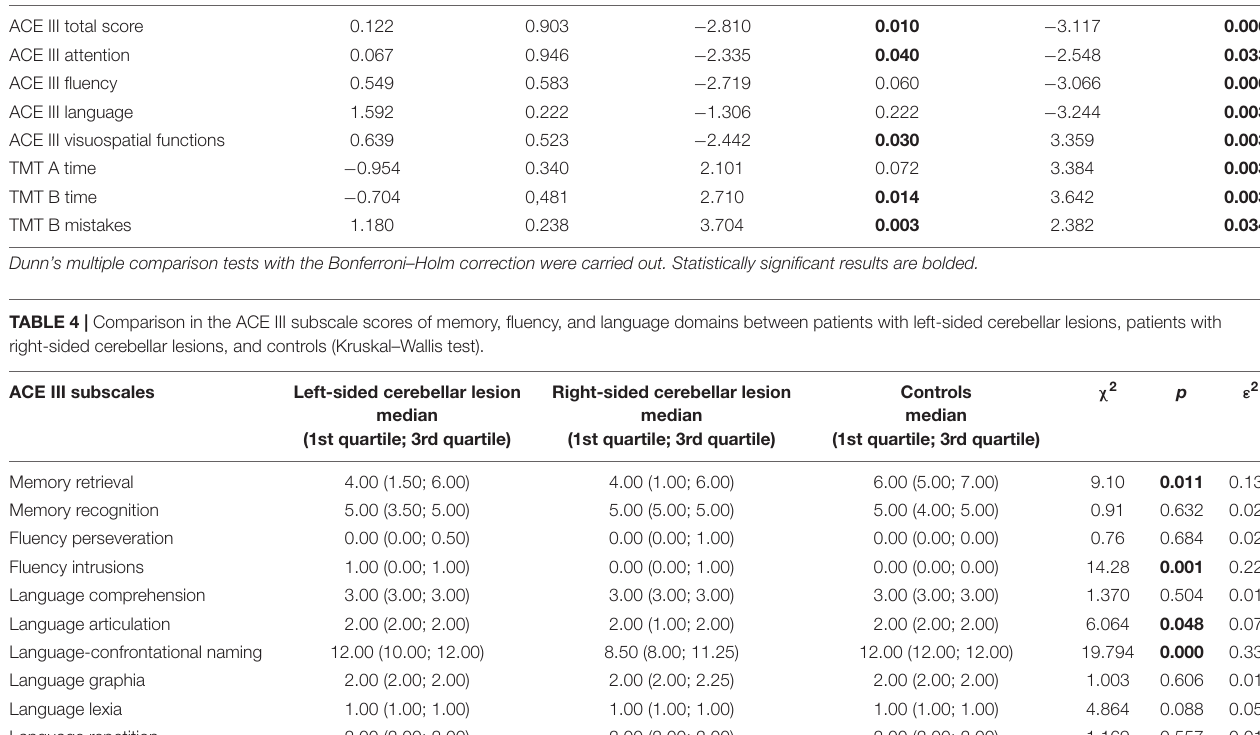
Right-sided cerebellar lesion vs.